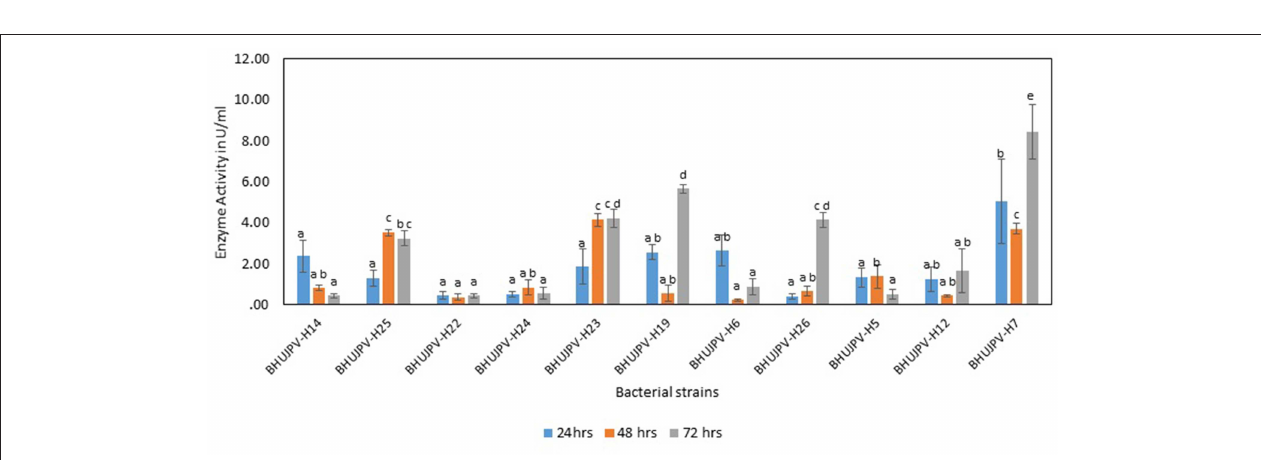
FIGURE 4 | β -glucosidase activity of different bacterial strains. Values are the mean ± SE (standard error). Mean values in each bar with the same alphabet superscript(s) do not differ significantly, but different alphabet superscript is showed significantly different between each treatment by Duncan post hoc test ( p ≤ 0.05).